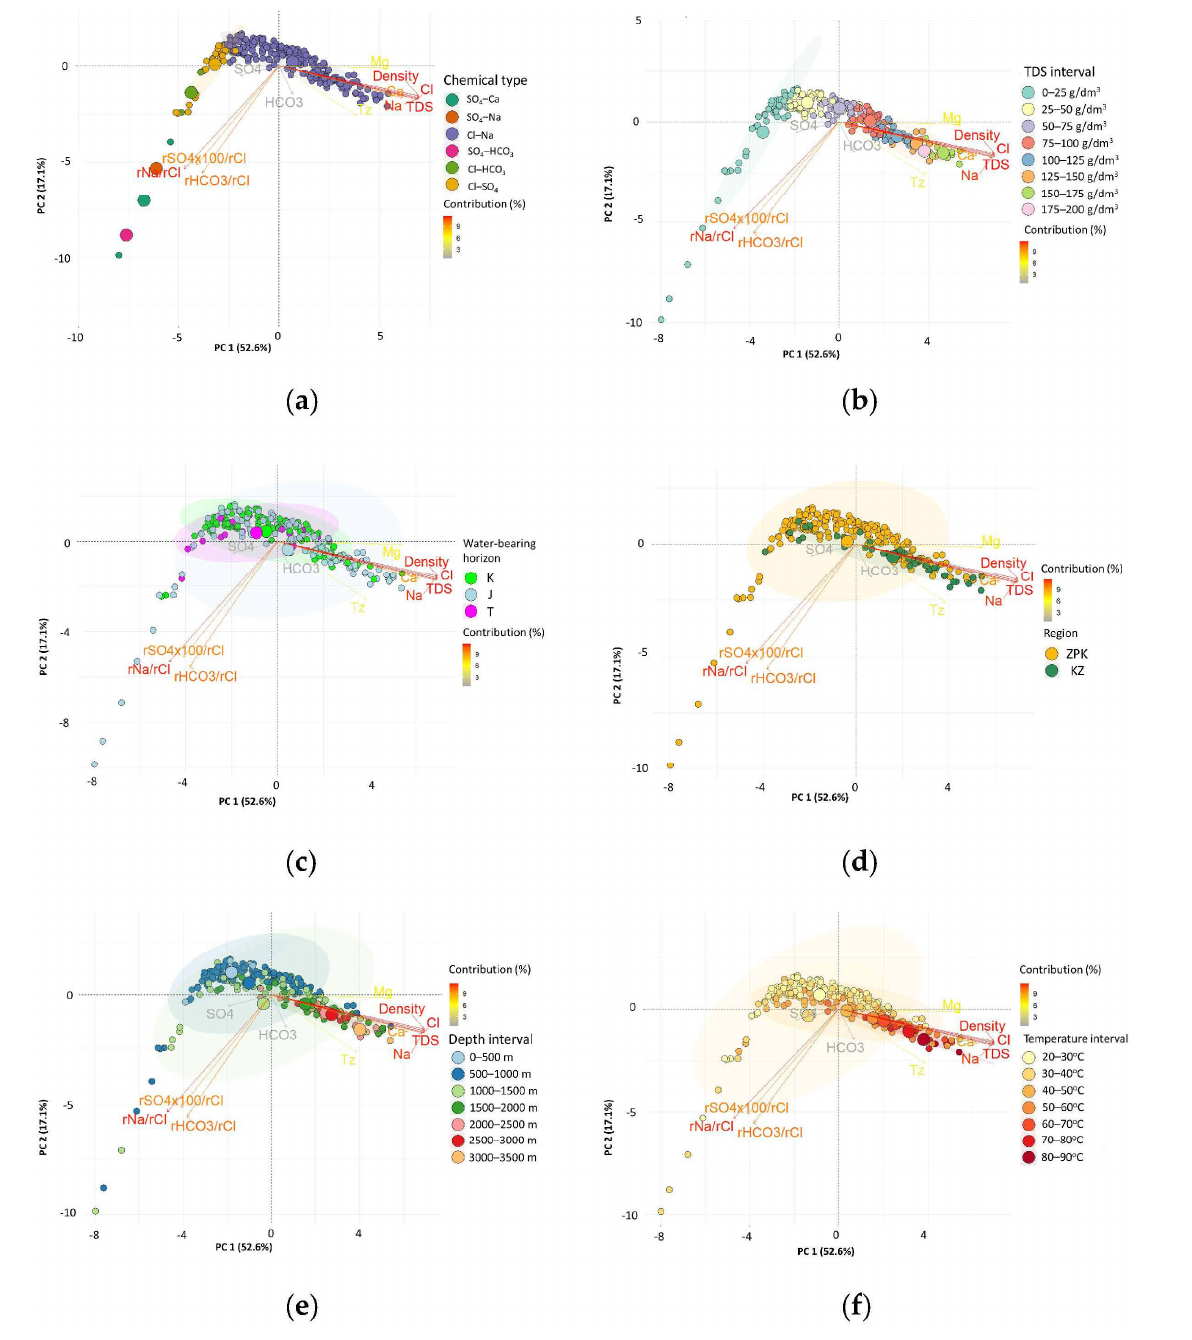
Figure 9. Biplot of factor coordinates for the cases and variables as a result of the Principal Component Analysis on the surface of PC 1 and PC 2, on the background of: ( a ) the chemical type of the water; ( b ) TDS of the water; ( c ) water-bearing horizon; ( d ) region; ( e ) depth; and ( f ) estimated temperature